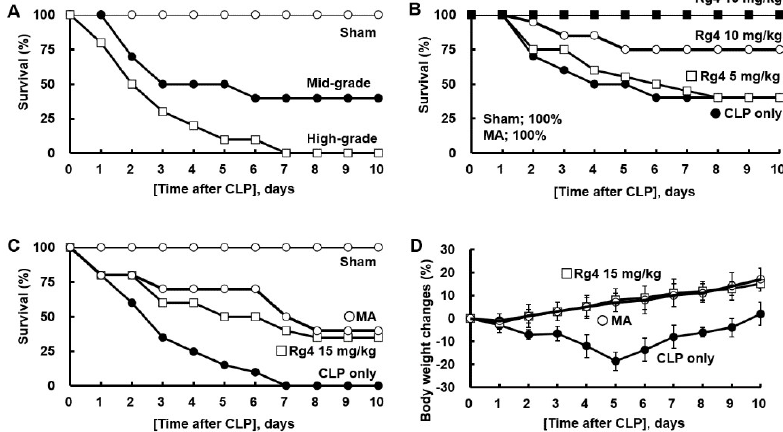
Figure 1. Protection of mice from the morbidity and mortality of sepsis by Rg4 after the CLP procedure. ( A ) Survival rates after the induction of different (mid or high) severity grades of sepsis by CLP. ( B , C ) Each group consisted of 10 mice and received intravenous injections of vehicle, MA (0.7 mg/kg) or Rg4 (5, 10, or 15 mg/kg) in 0.5% DMSO at 24 h after mid- ( B ) or high-grade ( C ) CLP. Survival rates of challenged mice were monitored for 10 days. ( D ) Body weight changes were measured during the period in Figure ( B ). All values are presented as the mean ± SD of three separate experiments. * p < 0.01 vs. CLP group for Rg4 or MA in figure ( D ).